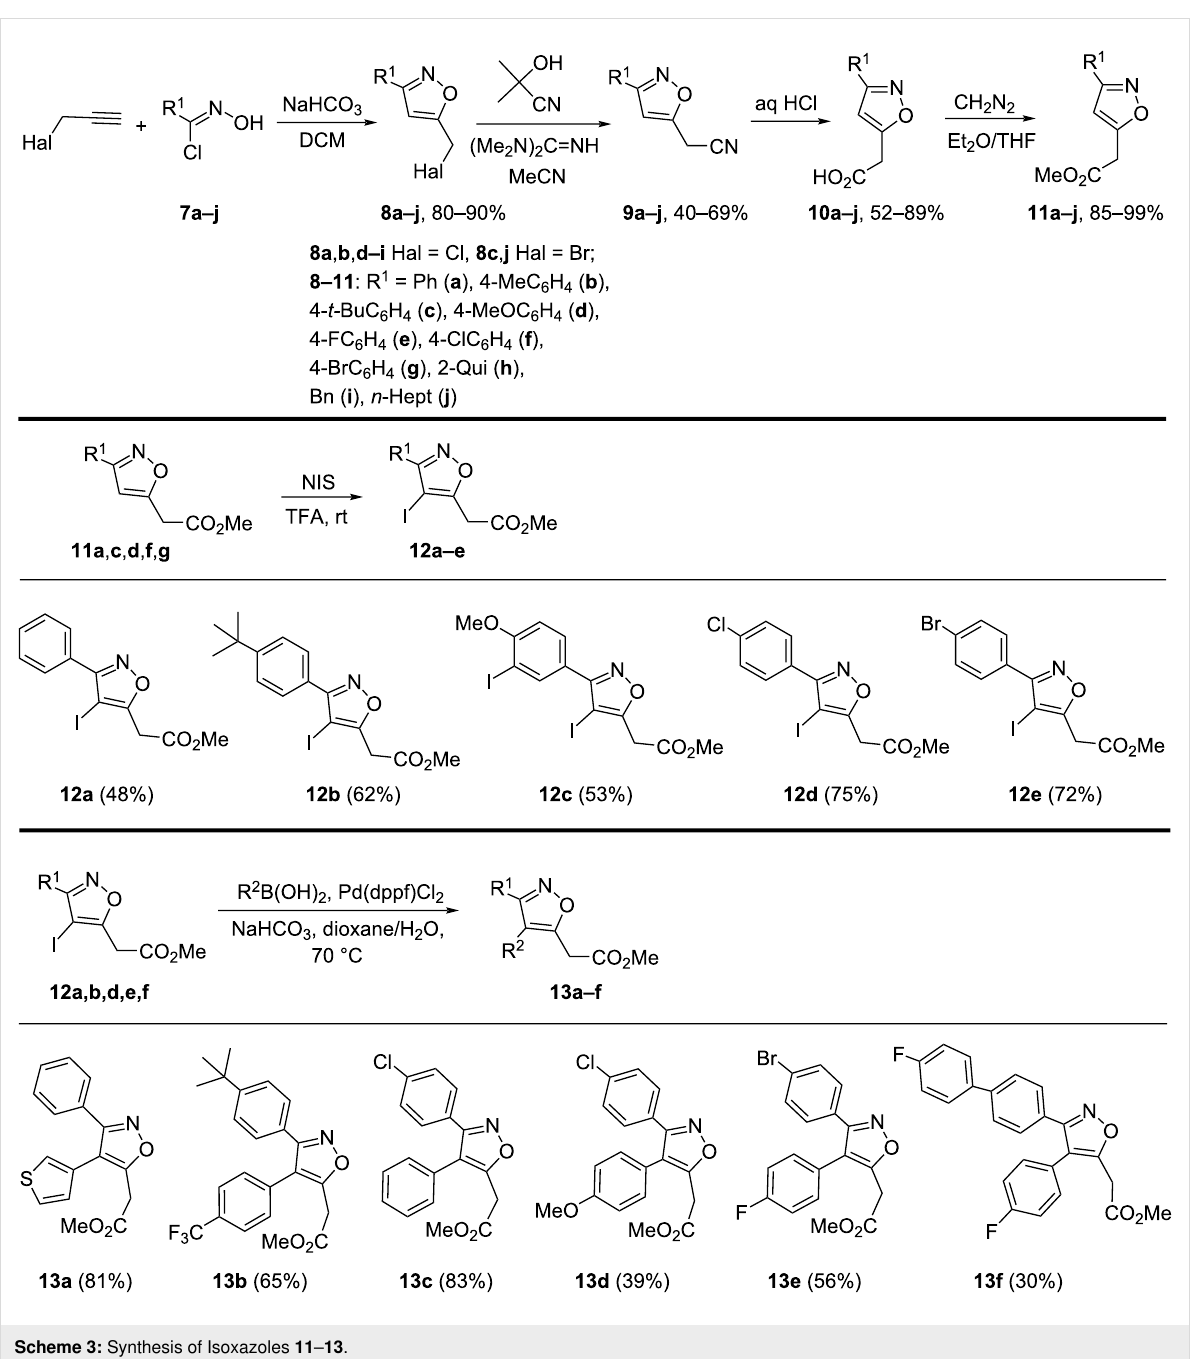
Isoxazoles 1 , except for isoxazole 1a , were synthesized in 44–98% yield by acylation of isoxazoles 11 , 12 and 13 with acyl chlorides in the presence of NaH (Scheme 4). For the prep- aration of isoxazole 1a propionic anhydride was used. Further, isoxazoles 1 were reacted with Mo(CO) 6 /H 2 O/MeCN under the optimal conditions to give pyridones 2 (Scheme 5). Isoxazole 1j with Mo(CO) 6 /H 2 O/MeCN gives the